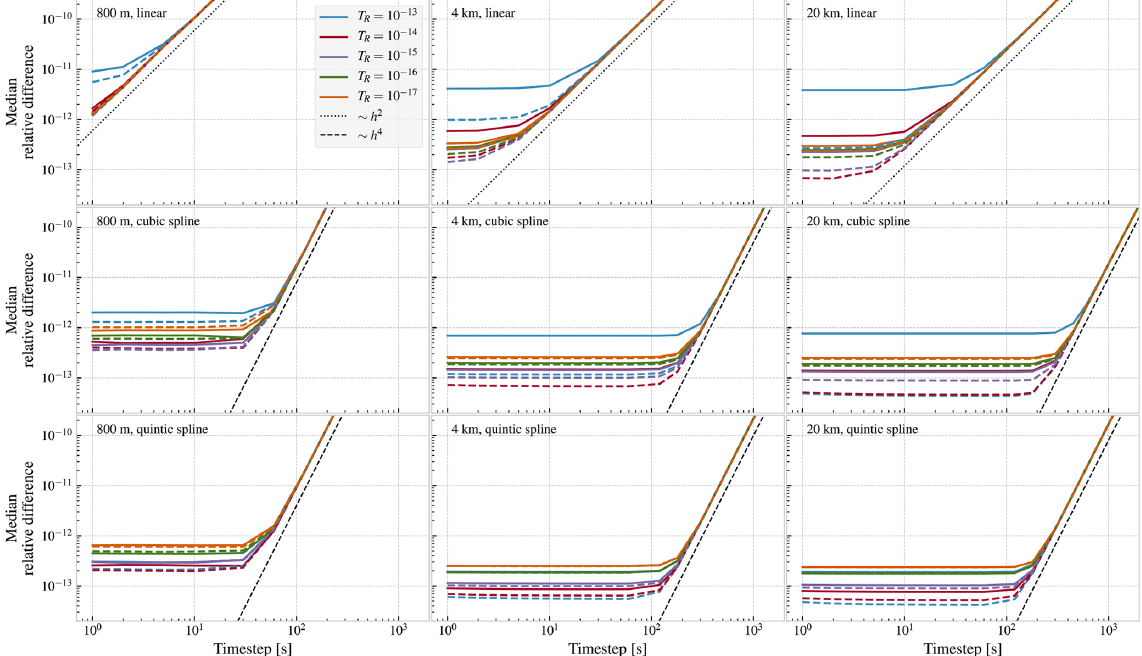
Figure A1. Median relative difference (Eqs. A1a and A1b) between the fourth-order Runge–Kutta solutions and the Dormand–Prince 8(7) solutions, as a function of the time step for the Runge–Kutta method, and shown for different tolerances for the Dormand–Prince method. The regular Dormand–Prince 8(7) is shown as continuous lines, and the special-purpose variant is shown as dashed